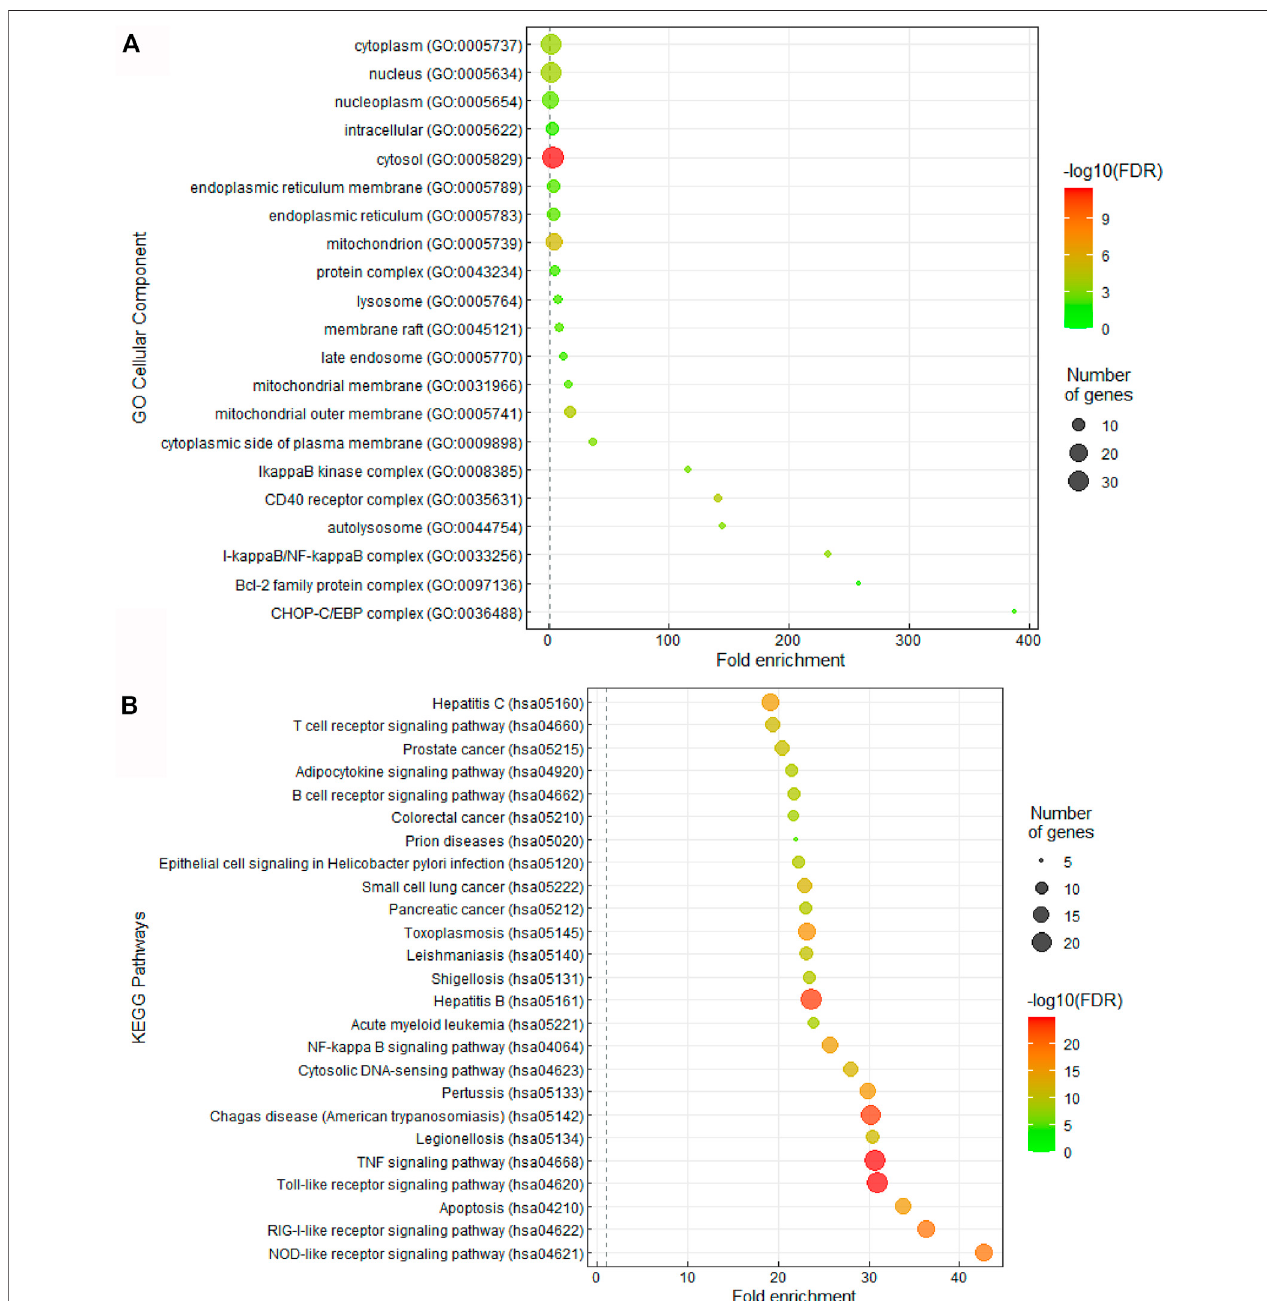
FIGURE3| CQandHCQtargetedTLRandIL-6signalingpathways. (A) Bubblegraphrepresentingsigni fi cantCellularComponentsfromthe47overlappedtarget genes.Thesizeofthedotsrepresentsthenumberofgenesthatcorrespond totheenriched GOterm. Thecolorimetryofthedotsrepresents thefalsediscovery rate. (B) Bubble graph representing signi fi cant KEGG pathways from the 47 overlapped drug target genes from the PubChem database. The size of the dots represents the number of genes that correspond to the enriched KEGG pathway.